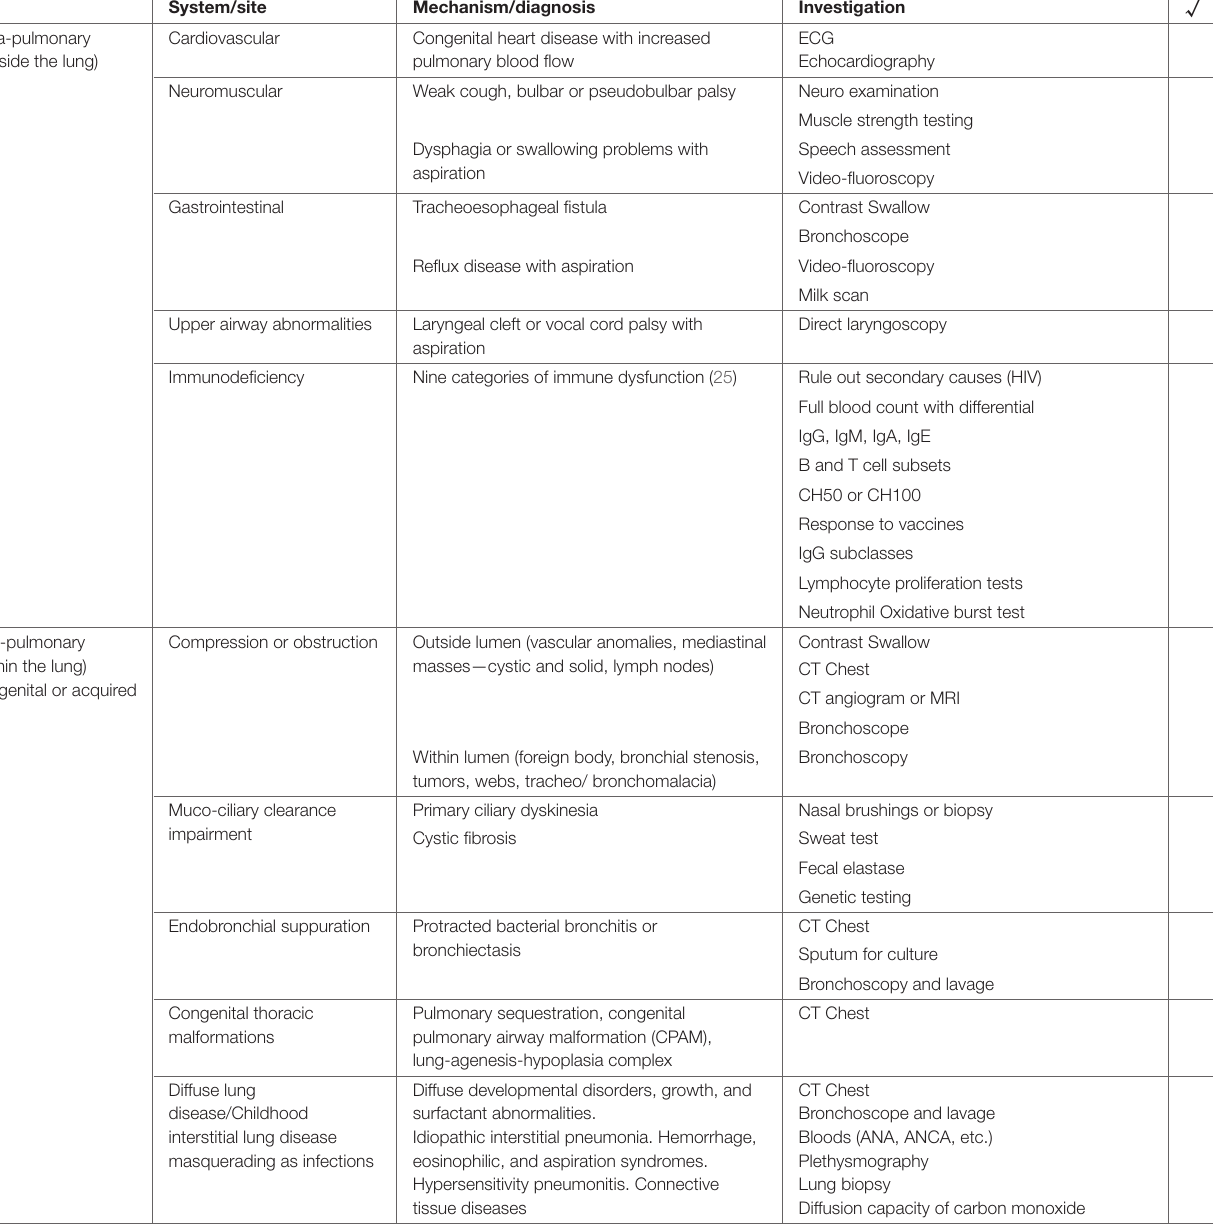
TABLE 1 | A checklist approach to further investigate children at risk of respiratory sequelae following lower respiratory tract